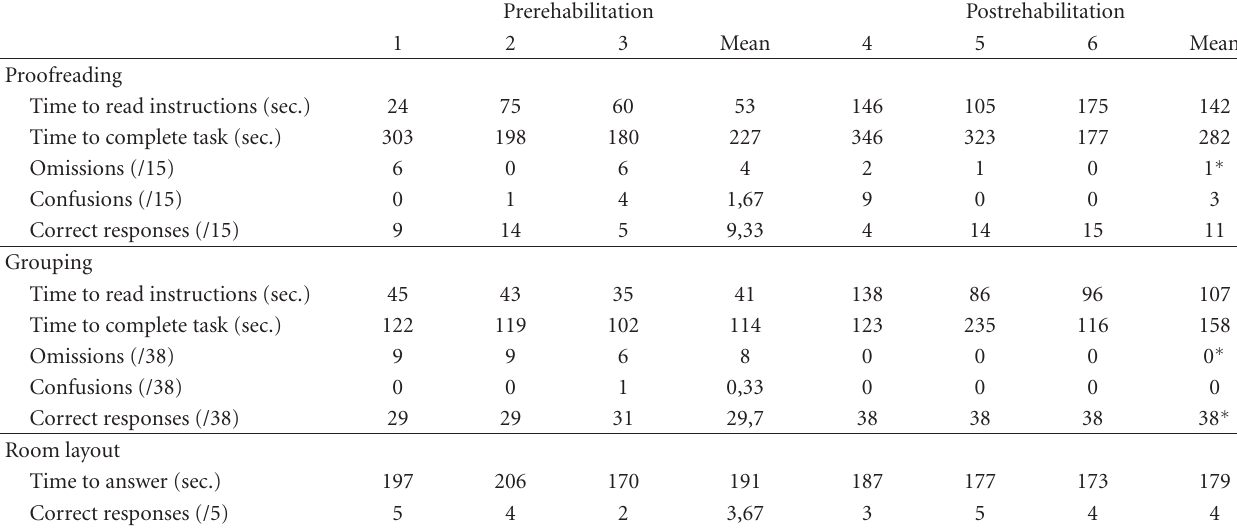
Table 3: G. O.’s results on the everyday paper-and-pencil